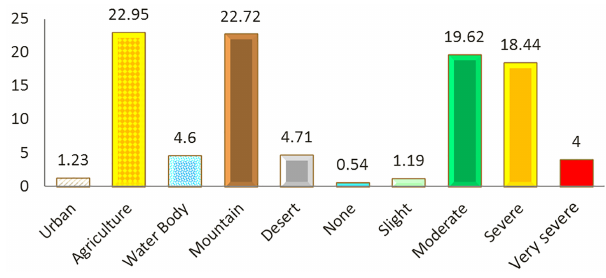
Figure 3. Percent of the land which is classified under each severity class of land degradation in the study area.